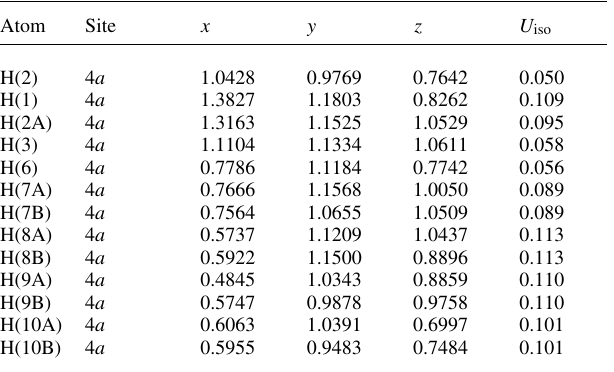
Table 2. Atomic coordinates and displacement parameters (in Å 2 )